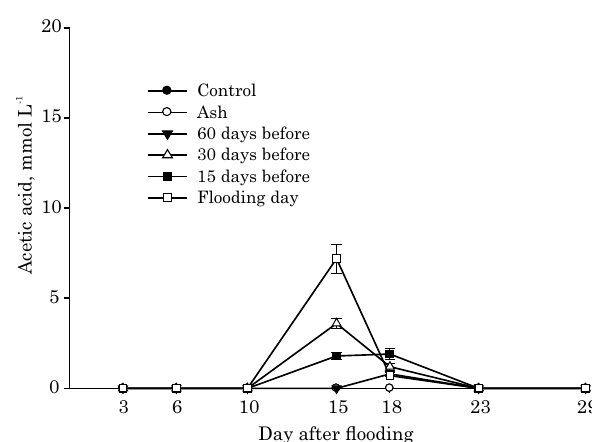
Figure 5. Acetic acid concentration in the soil solution after flooding as a functin of the time of incorporation of rice straw preceding the soil flooding or incorporation of the ash from burned straw. Control: without straw or ash; Ash: ash incorporated on the day of flooding; 60 days before: straw incorporated into the soil 60 days before flooding; 30 days before: straw incorporated 30 days before flooding; 15 days before: straw incorporated 15 days before flooding; and Flooding day: straw incorporated on the same day as